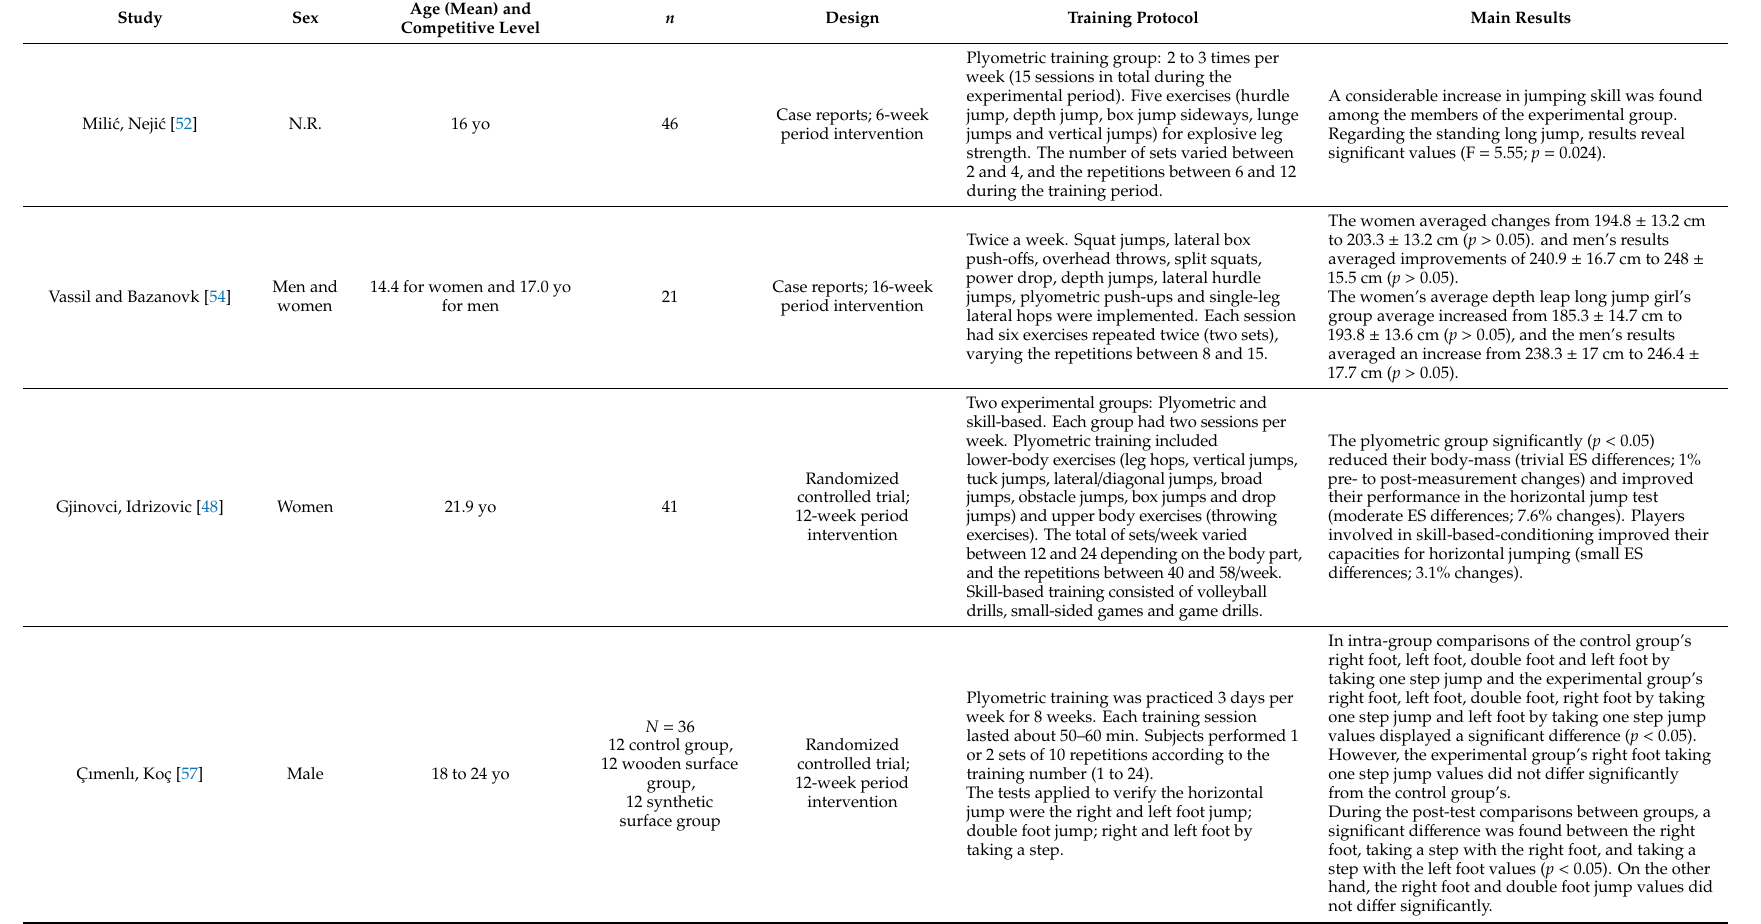
Table 4. Studies that investigated the e ff ects of plyometric training programs on horizontal jump